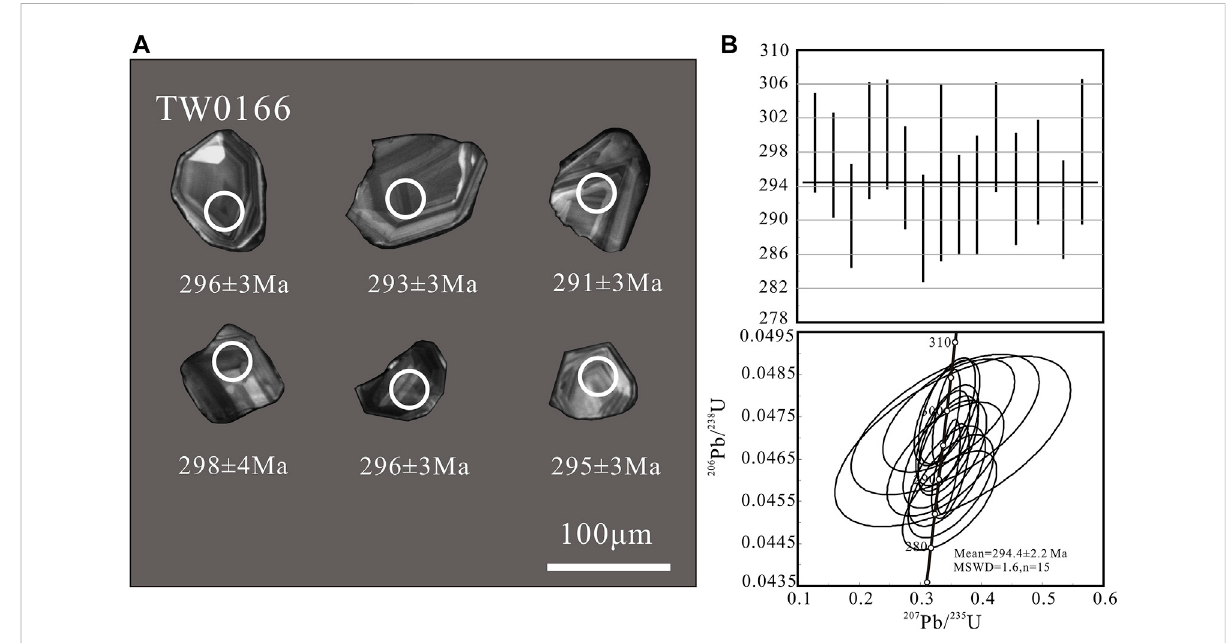
FIGURE 4 (A) Representative cathodoluminescence (CL) images of zircons from gabbro sample TW0166 (B) Zircon U-Pb concordia diagrams and weighed mean age for the gabbro sample